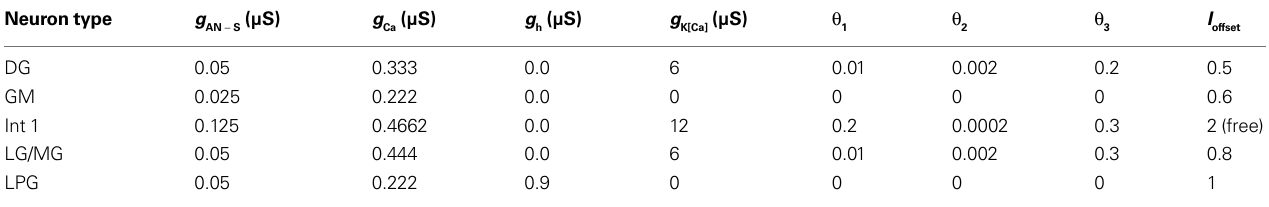
Table A1 | The parameters of the model neurons. Neuron type